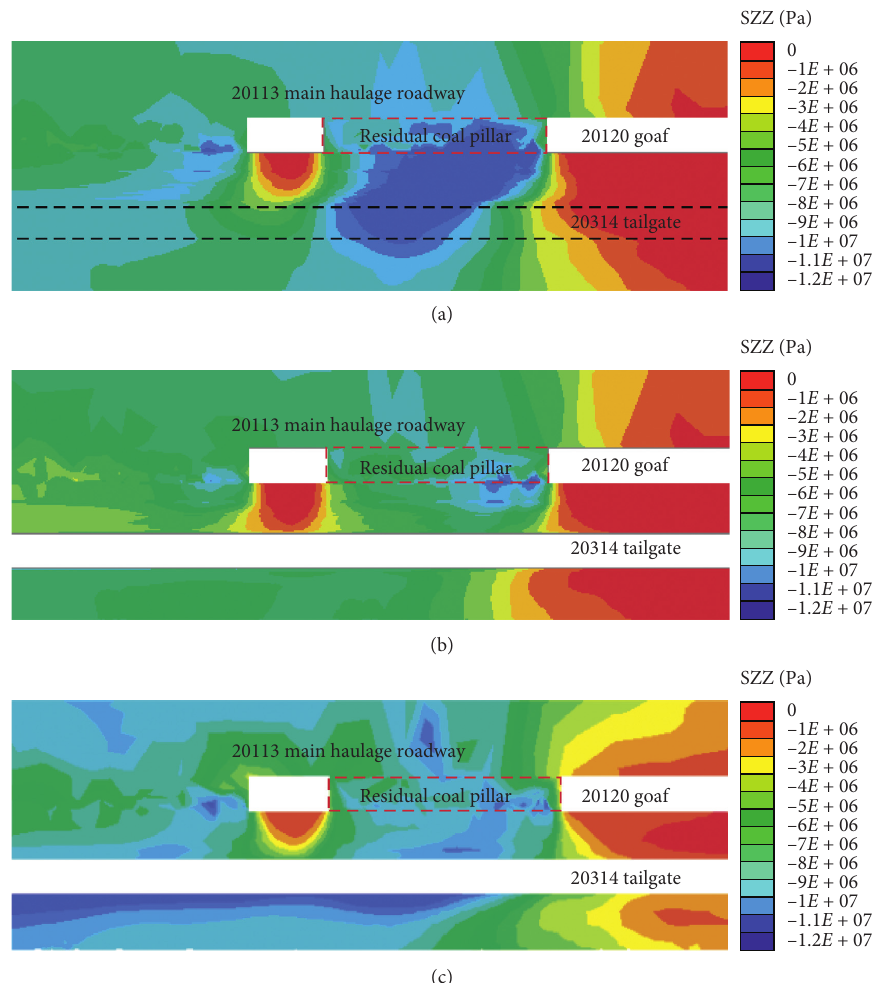
Figure 12: Stress variation of the 20314 auxiliary haulage roadway (parallel to the axis section of the roadway): (a) 2-2 upper coal seam excavation; (b) 20314 tailgate excavation; (c) 20314 panel